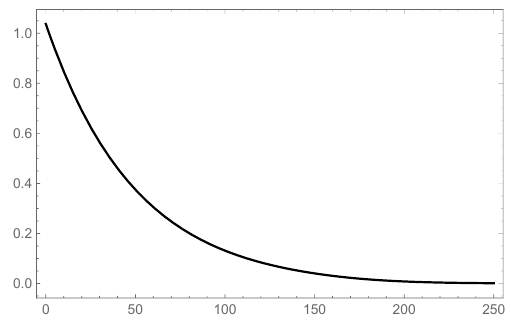
Figure 10 . The Bekenstein-Hawking entropy of the evaporating black hole after shockwave inser- tion. The vertical axis has been scaled